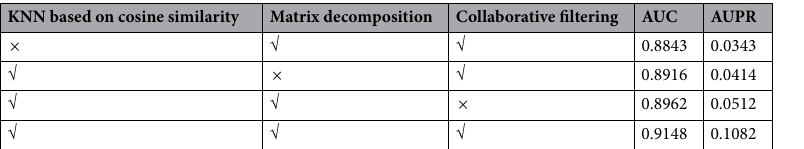
Table 1. The contributions of all components of the proposed